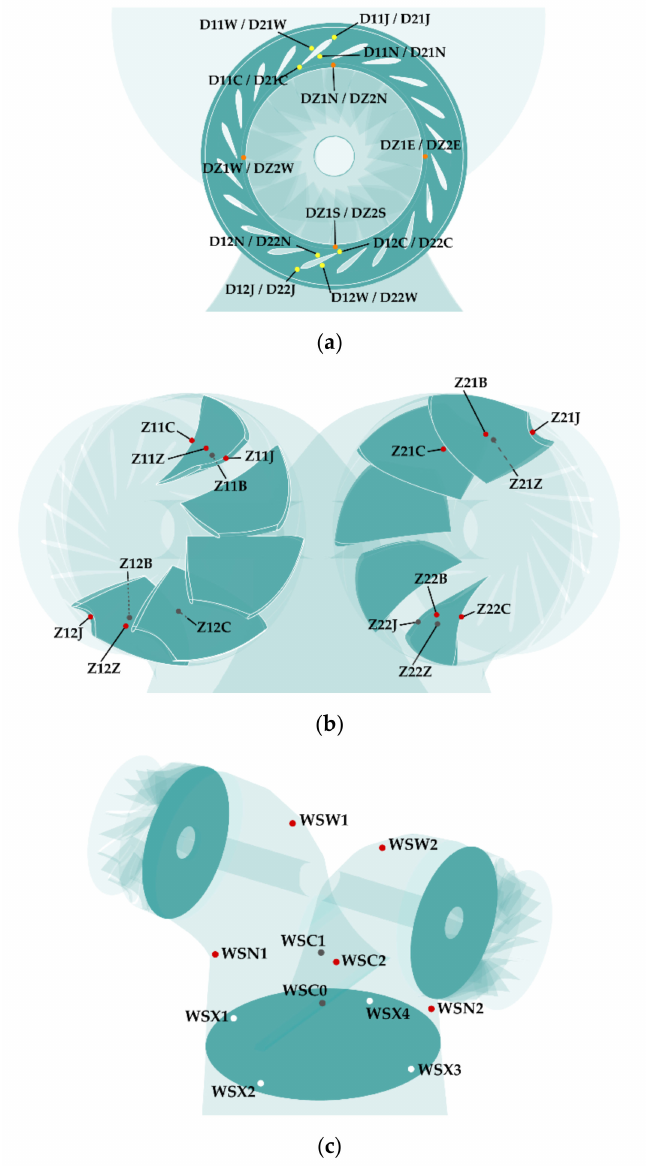
Figure 16. Pressure pulsation monitoring points in each part. ( a ) Monitoring points in guide vanes and bladeless zones; ( b ) monitoring points in runner blades; ( c ) monitoring points in the collection elbow and its